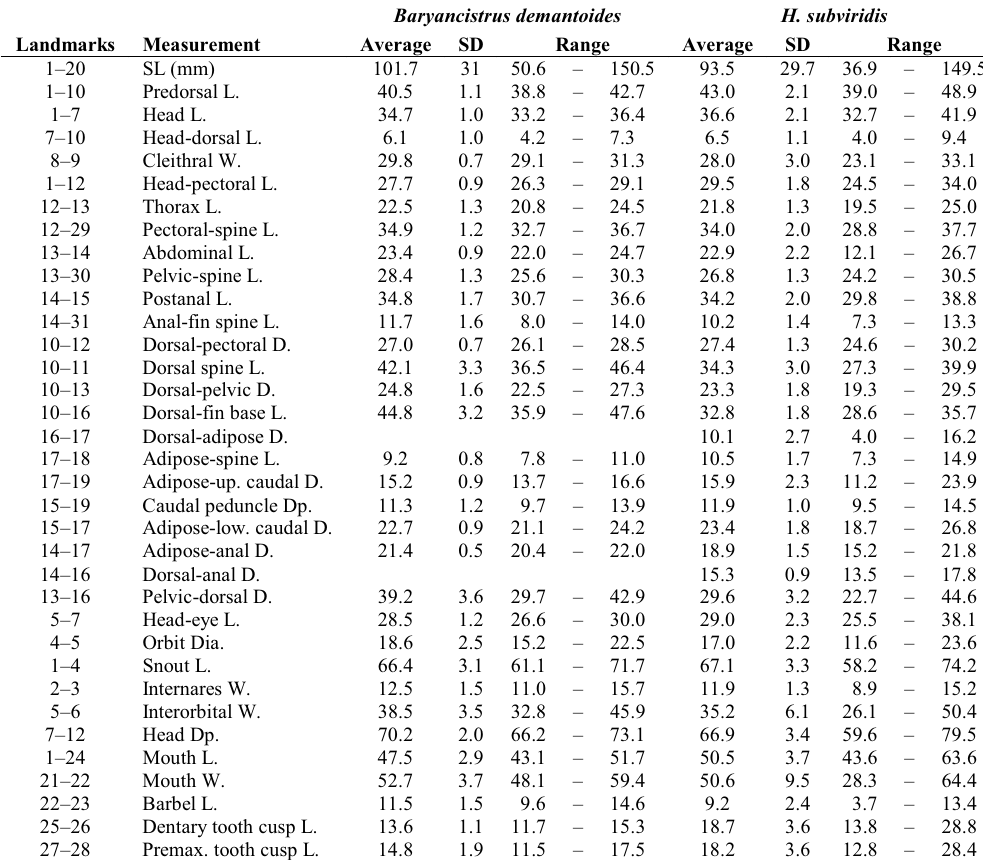
Table 1. Morphometrics of Baryancistrus demantoides (N = 11) and Hemiancistrus subviridis (N = 52 except dorsal-spine length N = 49). ‘Landmarks’ represents the two points between which the measurements were taken (from Armbruster 2003). Measurements are ratios of SL (predorsal l. to pelvic-dorsal l.) or head l. (head-eye l. to premaxillary tooth cup l). Baryancistrus demantoides H.